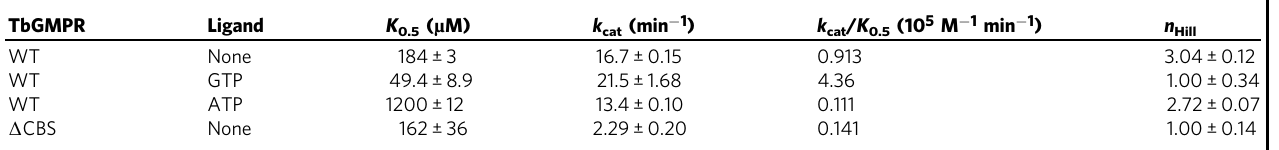
Table 1 Kinetic data for TbGMPR wild-type (WT) and TbGMPR Δ CBS. TbGMPR